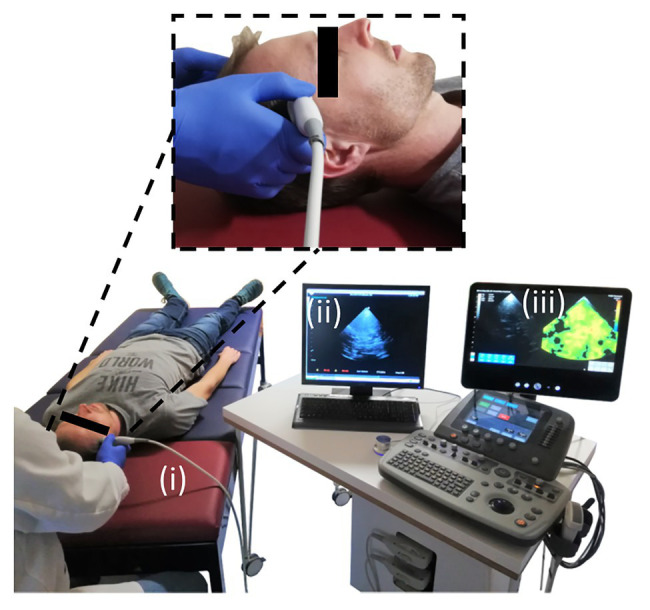
Experimental setup for conduct of cerebral THE. The setup comprised of three main components: (i) the customized patient bed with the vibration plate (red), (ii) the clinical ultrasound scanner, and (iii) the elastography computer with the integrated post-processing software. The magnification shows the positioning of the ultrasound probe over the volunteer’s temporal bone window for transcranial ultrasound.